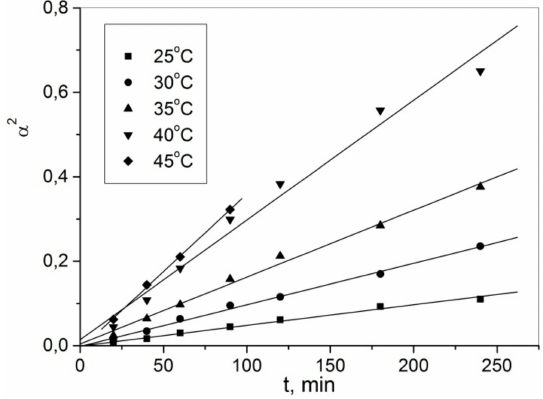
Figure 10. The plot of α 2 vs time for Cu extraction at di ff erent